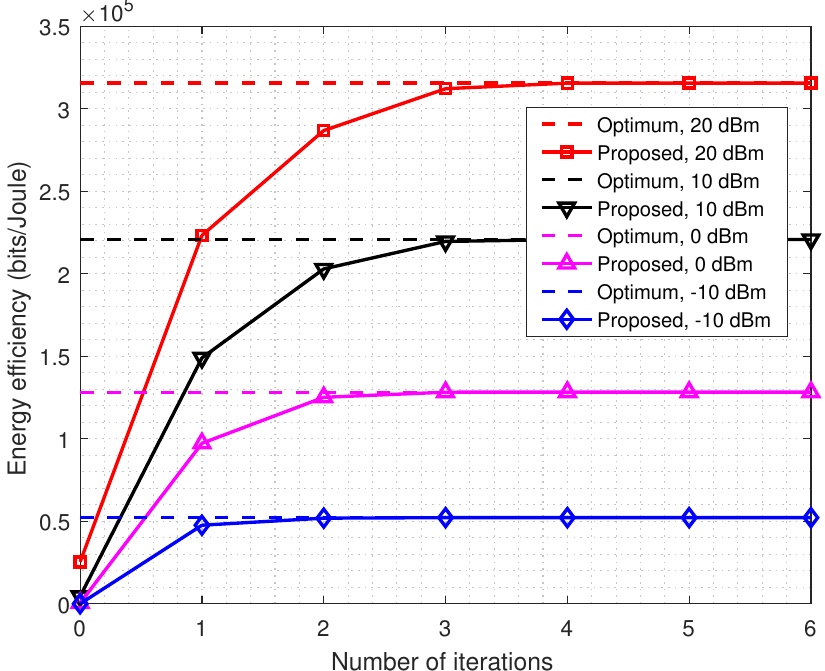
Figure 1. Convergence performance of the proposed energy-efficient multicast power allocation algorithm for different values of multicast power budget P max